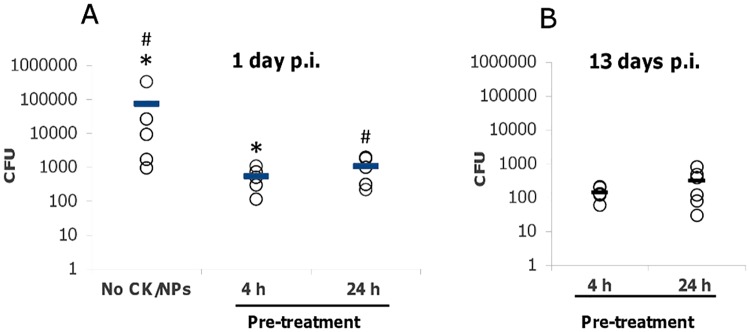
Bacterial load in LNs of mice pre-treated with CK-loaded MPs and control mice at 1 day (A) and 13 days (B) post challenge with 4x106 of B.a. spores in 20 μl of PBS per hind footpad.Bars indicate arithmetic means in each group. Mann-Whitney U-Test, * p = 0.02, # p = 0.14, n = 4–6 per group.